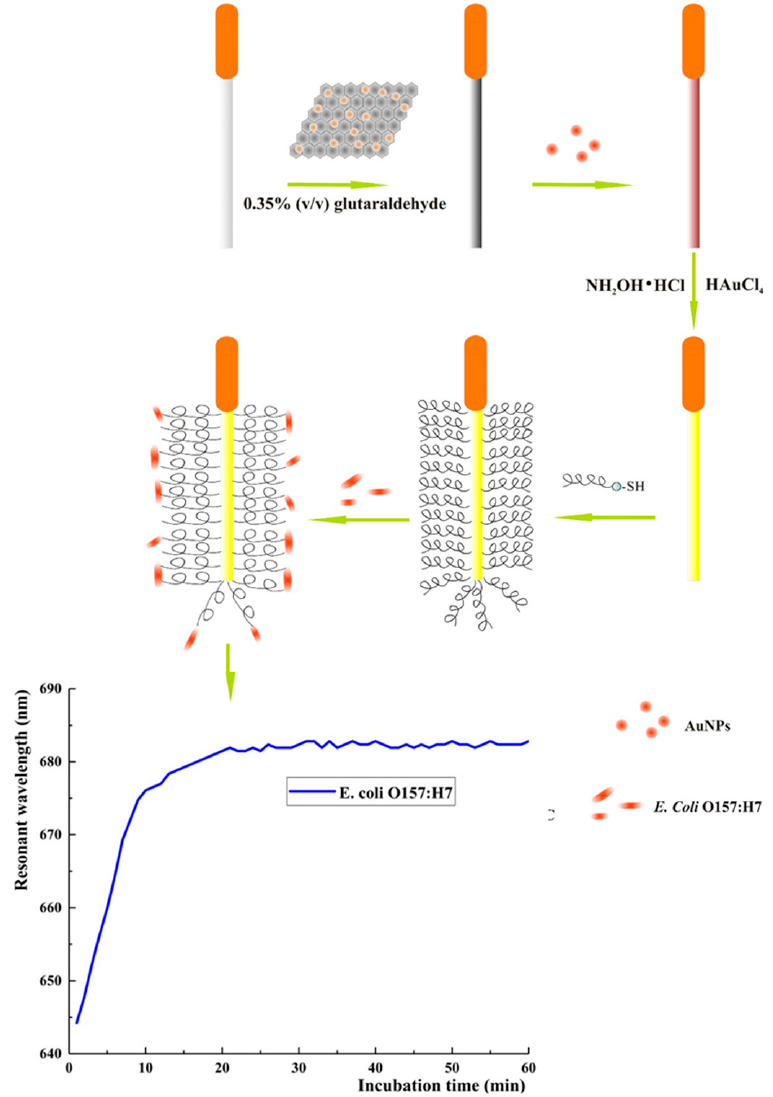
Figure 14. Schematic illustration of optical fiber SPR detection of E. coli O157:H7 [114] . Copyright 2018, Elsevier.